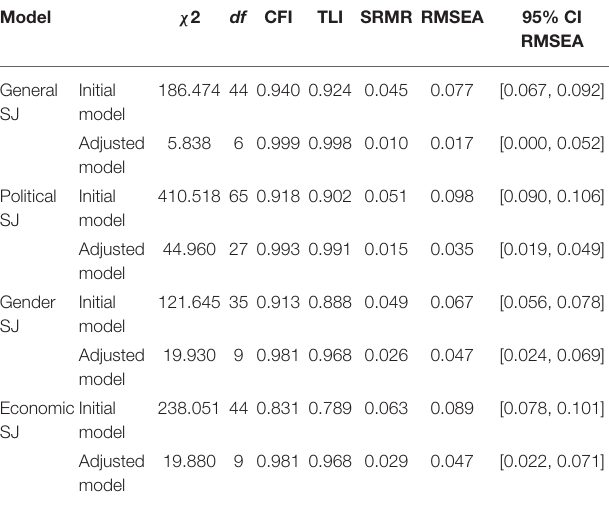
TABLE 3 | Study 2 CFA